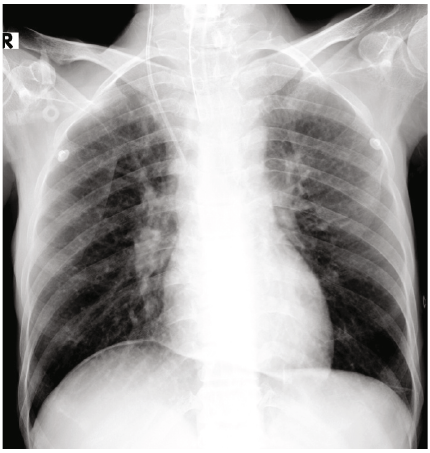
Figure 2: Chest X-ray after adjusting tracheostomy